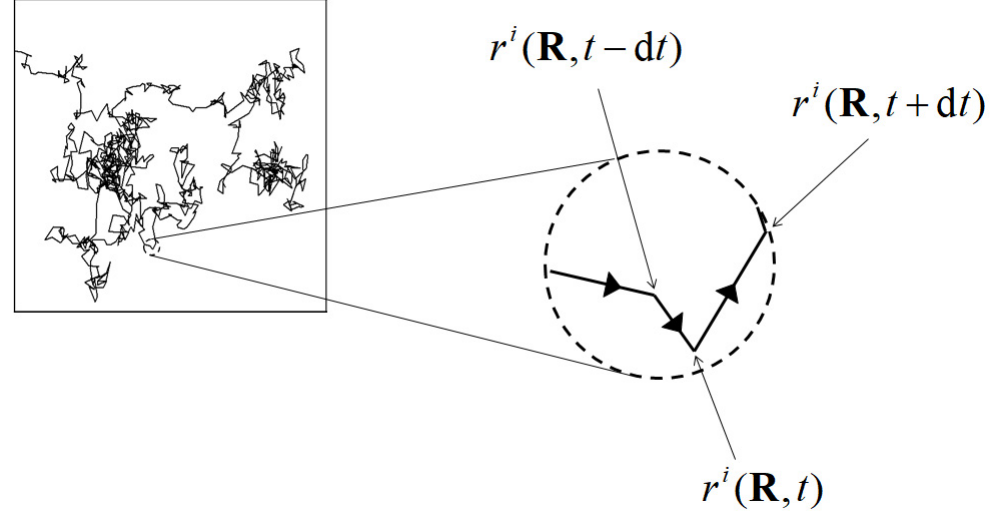
Figure 1. An example of the typical trajectory of Brownian motion. The positions at t − d t , t and t + d t are denoted by r i ( R , t − d t ) , r i ( R , t ) and r i ( R , t + d t ) ,